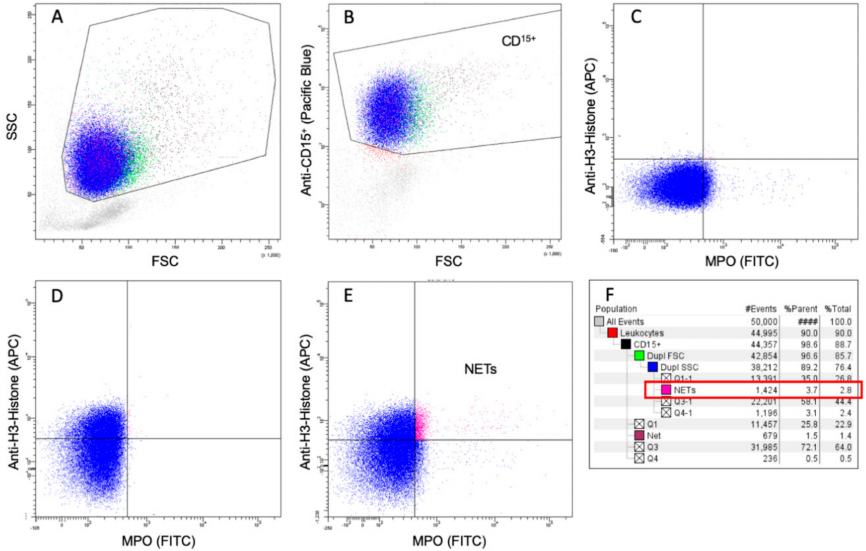
Figure 1. Description of the flow-cytometric gating strategy. First, leucocytes were targeted ( A ) and neutrophils identified as CD15 + -cells ( B ). Second, the fluorescence-minus-one (FMO) technique was used to set the gating borders of MPO- and anti-H3-Histone-antibody ( C , D ) and last, MPO- and anti-H3-Histone-positive cells were defined as surrogates for NETs ( E ). Results are shown as the percentage of gated neutrophils ( F , red box). Abbreviations: APC: Allophycocyanin; CD: Cluster of Di ff erentiation; FITC: Fluorescein isothiocyanate; FSC: Forward Scatter; MPO: Myeloperoxidase; NETs: Neutrophil Extracellular Traps; SSC: Side